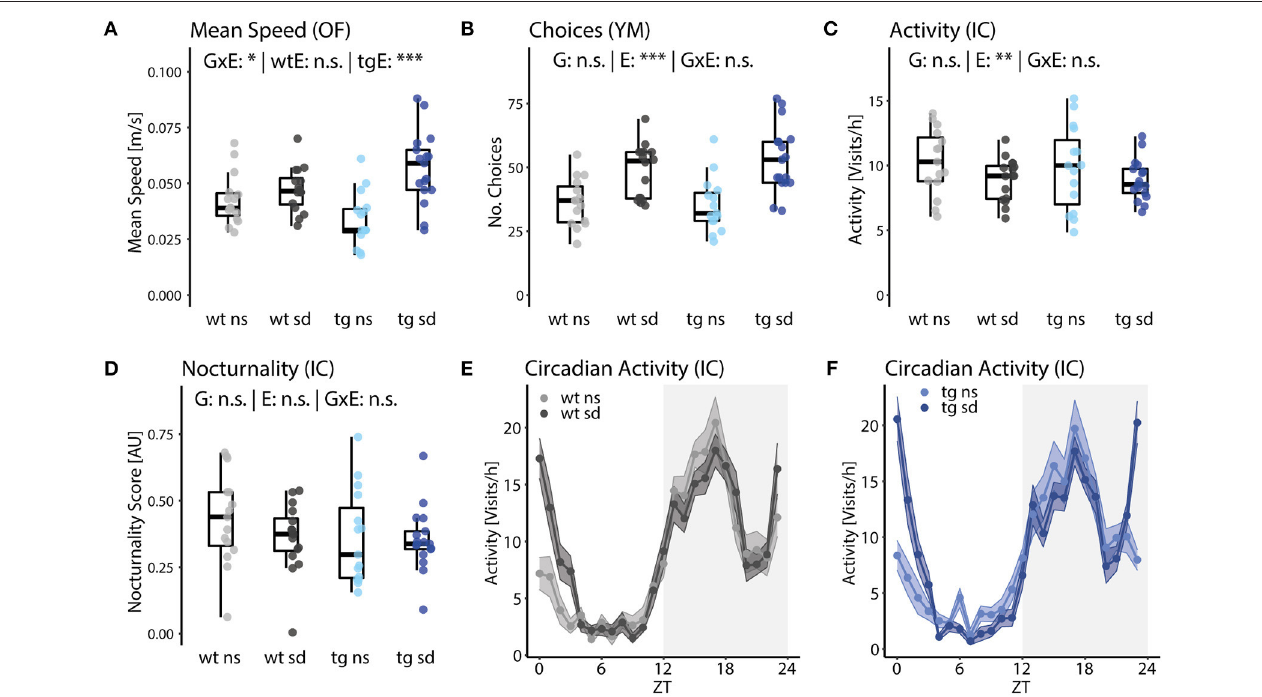
FIGURE 4 | Psychosocial stress increases novelty-induced but not general locomotor activity. (A) Mean speed in the open field test revealed a statistically significant interaction of genotype and environment [G × E: F (1,49) = 8.4, p = 0.020]. A subsequent one-way ANOVA for each genotype shows that social defeat induces increased mean speed only for tg animals [tgE: F (1,30) = 20.4, p = 9.0E-5]. (B) The number of choices in the Y-maze test were significantly increased by social defeat, as well, without a significant interaction with genotype [E: F (1,49) = 23.0, p = 2.8E-4]. (C) Overall activity in the IntelliCage over 5 days was found to be reduced in stressed mice [E: F (1,49) = 12.5, p = 0.0043]. (D–F) Nocturnality of activity in the IntelliCage did not differ significantly between groups. However, a repeated-measures ANOVA of hourly bins revealed that circadian allocation of activity was influenced by social defeat [ExZT: F (23,1,380) = 9.05, e = 0.52, p[HF] = 2.52E-16]. Data are shown as box plots with whiskers extending to no more than 1.5-fold IQR; * p < 0.05, ** p < 0.01, *** p < 0.001, n.s., not significant; p -values are FDR-corrected and refer to Wilk’s lambda testing two-way ANOVA; n = 15/17/15/17. G, genotype term; E, environment term; G × E, interaction term; ExZT, Interaction of environment